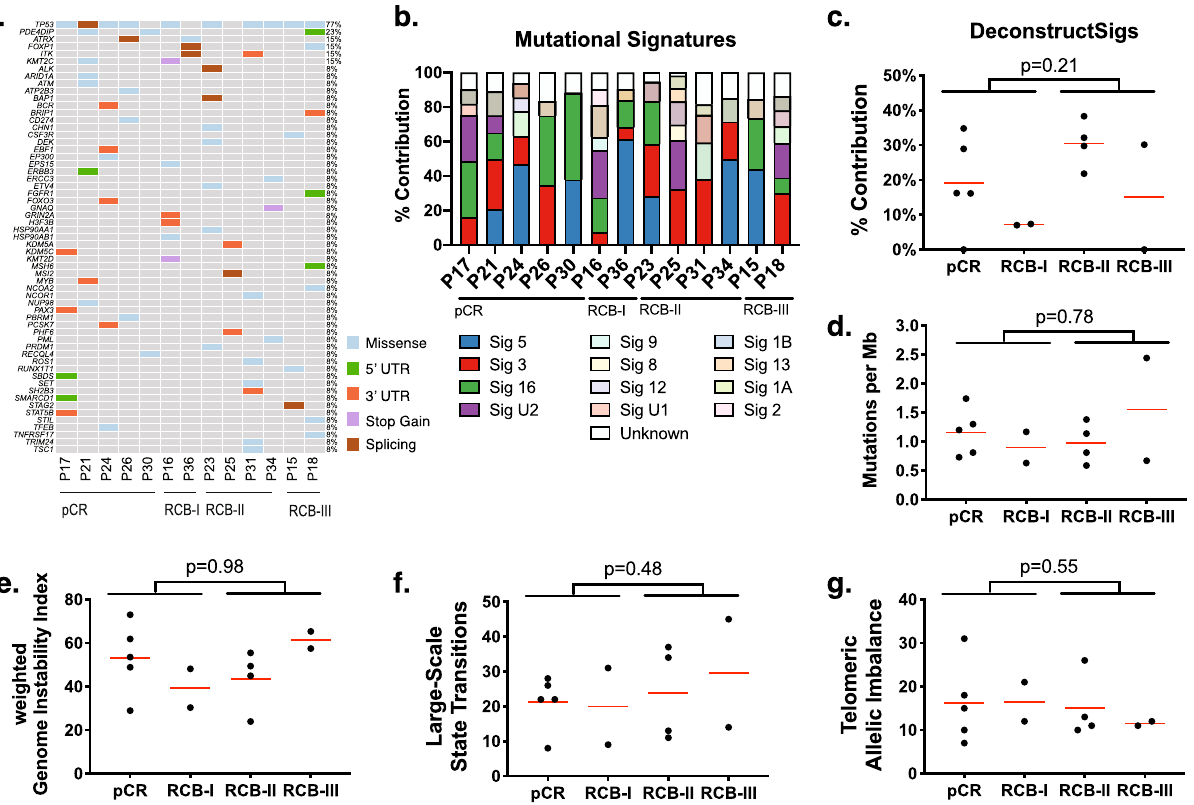
Fig. 1 Genomic pro fi le of data set. a This oncoplot shows the somatic mutations in cancer-associated genes from the COSMIC database found in this cohort. Each row represents a mutated gene and each column represents a patient. The patients are grouped by RCB. The rectangles are colored according to mutation status. b This plot shows the predicted contribution of each mutation signature ( y -axis), as predicted by DeconstructSigs, to the overall mutational processes in the tumors (columns). The signatures are distinguished by color. c The percent contribution of signature 3 (indicative of homologous recombination de fi ciency) as predicted by DeconstructSigs, are shown on the y -axis for each of the tumors. The % contribution from signature 3 is separated according to the response of each tumor. The red line indicates mean contribution, and the p -values are calculated using an unpaired two-sided Student ’ s t test comparing pCR and RCB-I against RCB-II and RCB-III. d The tumor mutation burden ( y -axis) is shown for each of the tumors, separated by response. The red lines indicate average mutations. The p -values are calculated as in c . e The weighted genome instability index ( y -axis) is shown for each tumor, separated by response. The mean indexes are shown by red lines. The p -values are calculated as in c . f The number of large-scale state transitions ( y -axis) is shown for each tumor, separated by response. The red lines indicate means. The p -values are calculated as in c . g The number of telomeres with imbalanced alleles ( y -axis) is shown for each tumor, separated by response. The red lines indicate means. The p -values are calculated as in c